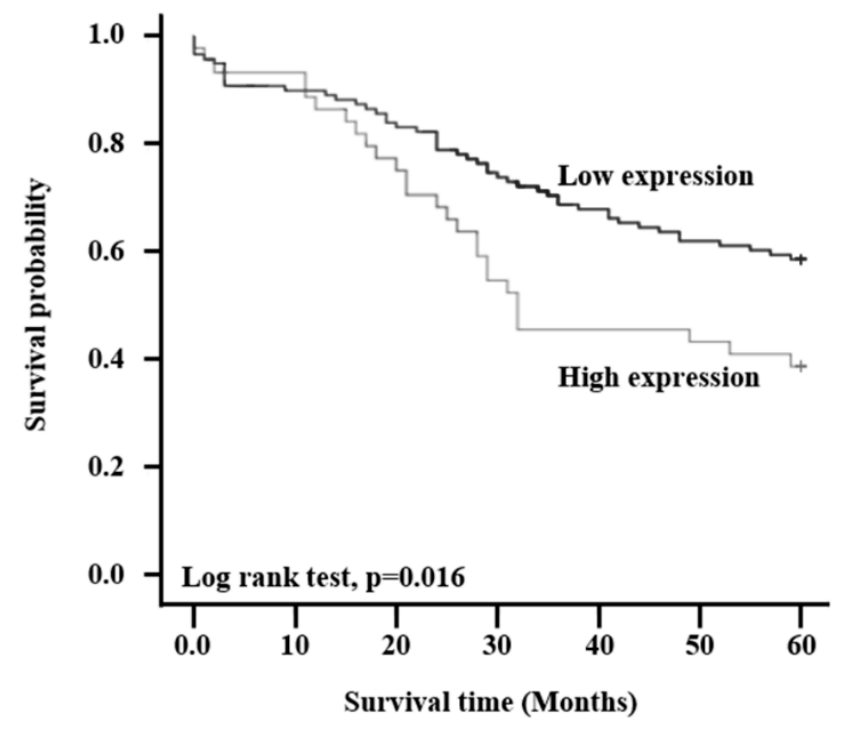
Figure 2. HJURP expression is related to overall survival in colorectal cancer patients. Patients were divided into two groups based on the expression of HJURP and survival rate was determined using Kaplan-Meier analysis ( p =